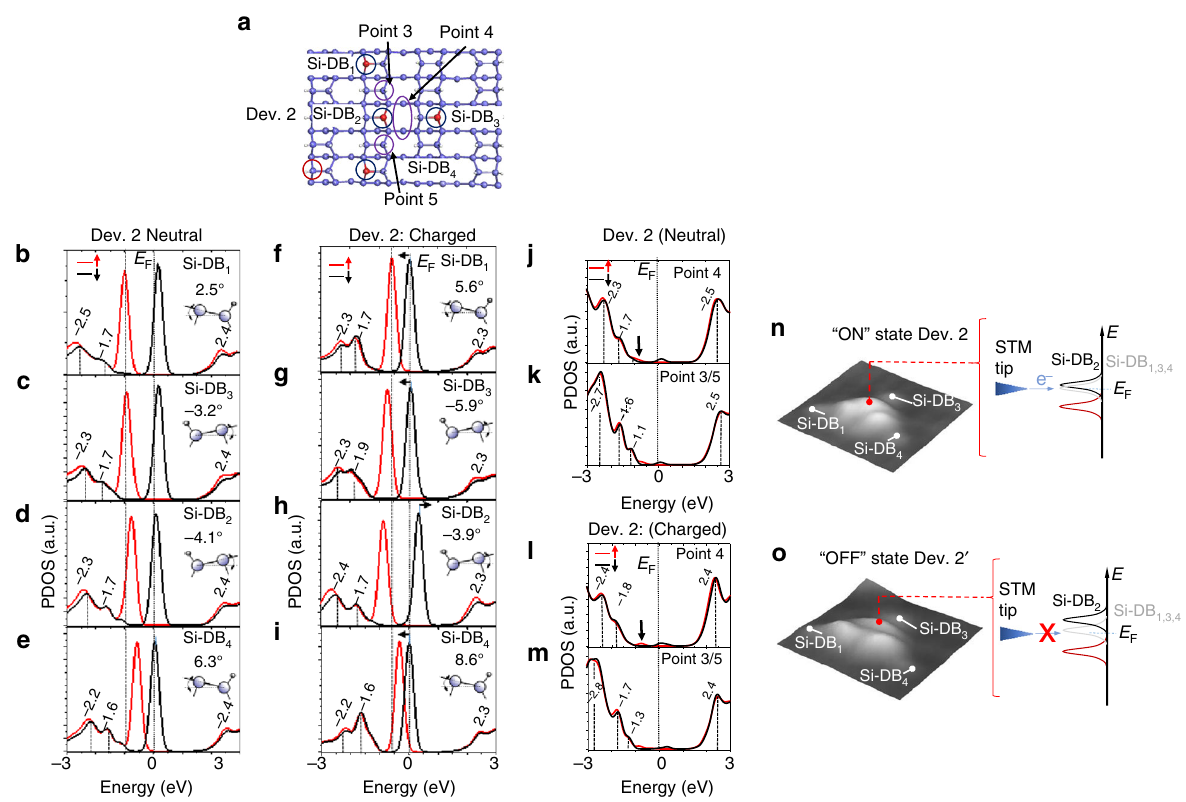
Fig. 6 Analysis of the neutral and charged states of Dev. 2. a Ball and stick sketch of the four Si-DB structures of Dev. 2. The blue and white balls are Si and H atoms, respectively. b – e PDOS curves of the spin-up (red) and spin-down (black) states calculated at the four Si-DB locations on Dev. 2 (neutral state). f – i PDOS curves of the spin-up (red) and spin-down (black) states calculated at the four Si-DB locations of Dev. 2 in its charged state Dev. 2 ′ . The tilt angles of the silicon dimers holding the Si-DBs are indicated in the insets. j – m PDOS curves of the spin-up (red) and spin-down (black) states calculated at the coupling positions 4, 3, and 5 in the neutral state Dev. 2 in j and k and the charged state Dev. 2 ′ in l and m . n , o Three-dimensional STM topographies of the Dev. 2 in its ON ( n ) and OFF ( o )